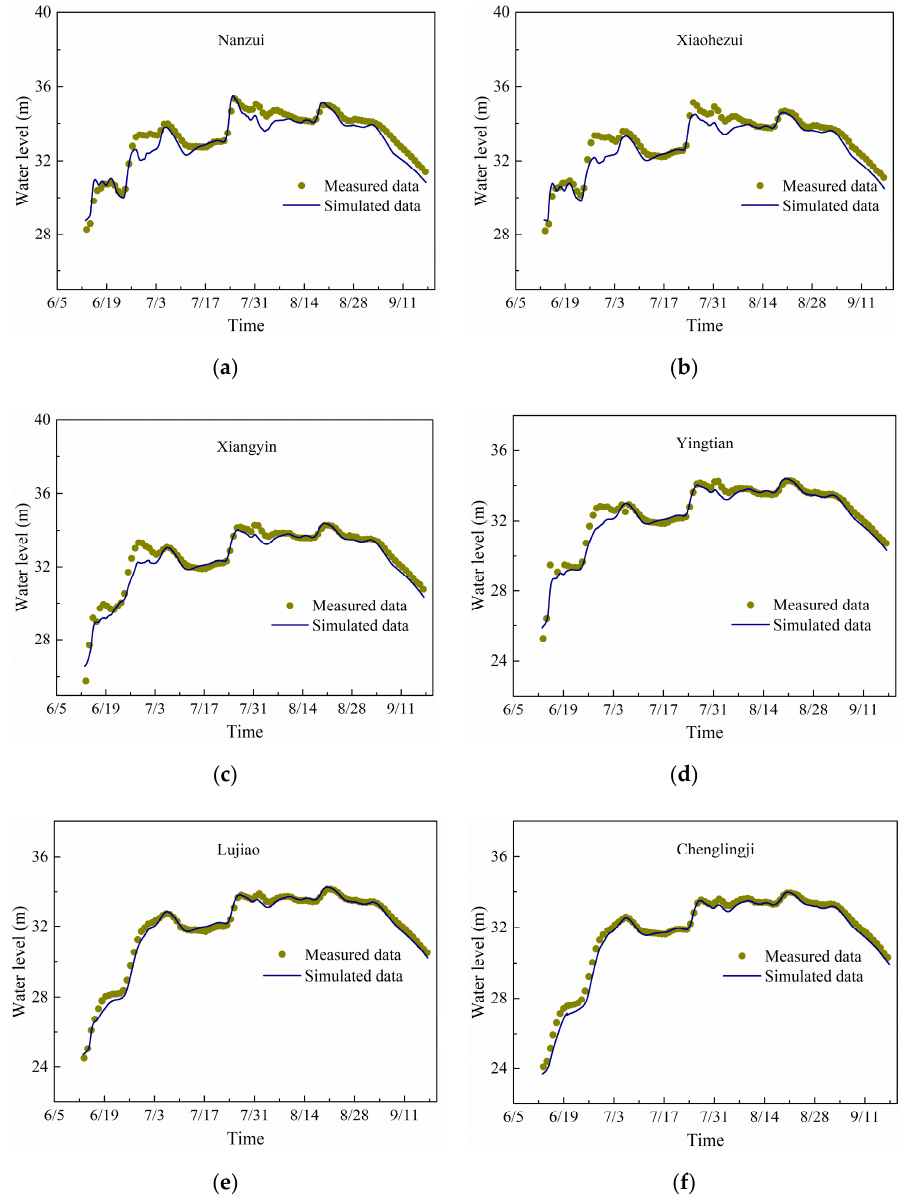
Figure 3. Comparison of water level process during the flood season (June to September) in 1998. ( a ) Nanzui; ( b ) Xiaohezui; ( c ) Xiangyin; ( d ) Yingtian; ( e ) Lujiao; and, ( f ) Chenglingji.